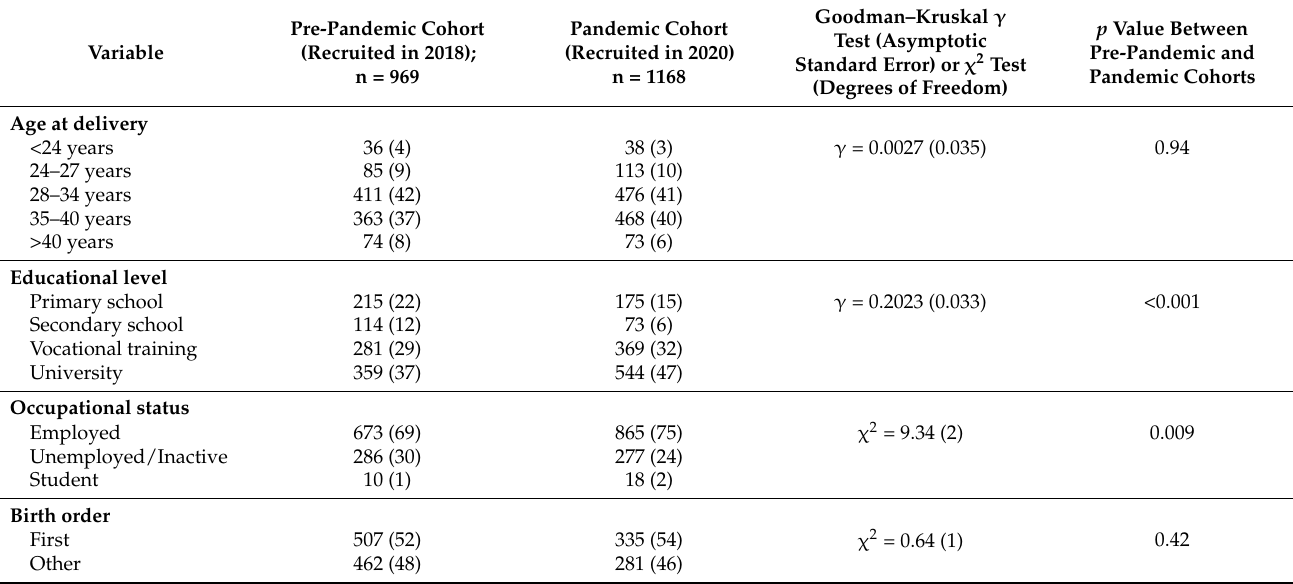
Table 1. Description of the cohorts included in this